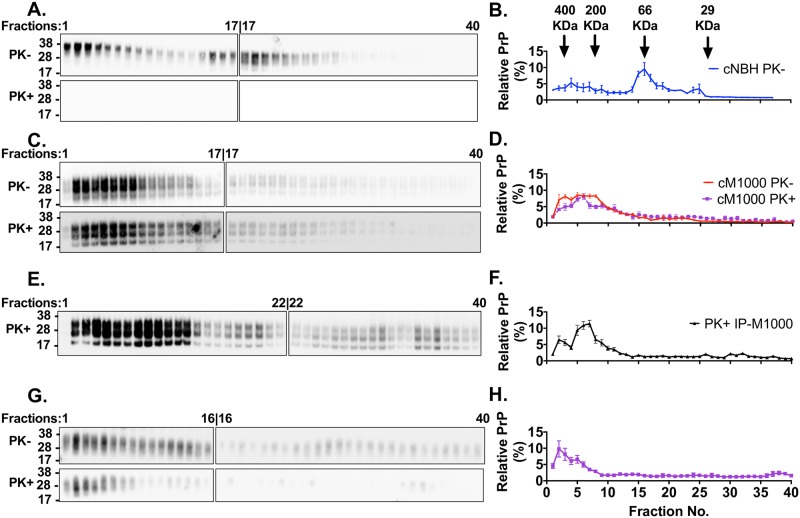
Prion acute synaptotoxicity is associated with increased levels of multimeric PrPSc species in ex vivo M1000 preparations.(A) Representative anti-PrP immunoblots of fractions collected following size exclusion chromatography of 10% (w/v) cNBH after clarifying centrifugation, solubilization in 4% (w/v) Sarkosyl and exhaustive dialysis. The fractions were immunoblotted before (-) and after (+) mild PK treatment (PK; 5μg/mL PK; incubated at 37°C for an hour). (B) Densitometric analysis of the immunoblots of cNBH fractions (n = 3) displayed as the percentage of PrP in each fraction over the sum of PrP levels in all the fractions. (C) Representative anti-PrP immunoblots of fractions collected following size exclusion chromatography of 10% (w/v) solubilized, dialyzed, and pre-cleared cM1000. The fractions were immunoblotted before (-) and after (+) mild PK treatment as described for (A). (D) Densitometric analysis of the immunoblots of cM1000 fractions (n = 3). (E) Representative anti-PrP immunoblots of fractions collected following size exclusion chromatography of at least modestly PK-resistant PrPSc, extracted from 1% (w/v) cM1000 by immunoprecipitation (IP) and eluted by a mild PK digestion (5μg/mL PK at 37°C for an hour) before being concentrated (10-fold to be equivalent to 10% w/v), solubilized, dialyzed, and pre-cleared for the size fractionation (PK+IP-M1000). (F) Densitometric analysis of the immunoblots of PK+IP-M1000 fractions (n = 2). (G) Representative anti-PrP immunoblots of fractions collected following size exclusion chromatography of solubilized, dialyzed, and pre-cleared 10% (w/v) M1000 brain homogenates containing only ~30% of the total PrP following selective removal of ~70% by immuno-depletion (dM1000). The fractions were immunoblotted before (-) and after (+) mild PK treatment (5μg/mL PK at 37°C for an hour). (H) Densitometric analysis of the immunoblots of dM1000 fractions (n = 3). (D & H) The levels of fractionated PrP with and without PK treatment were overlaid for illustration purposes and cannot be compared quantitatively because they were analysed independently. The effective molecular weights of PrP species collected in fractions one through 12 were larger than 100kDa consistent with multimeric species while those collected in fractions 15 through 40 were smaller than 100kDa (Molecular weight markers are indicated as arrows above B. (A, C, E, and G) Since all 40 fractions could not be loaded onto one 26-well gel, two 26-well gels were used for immunoblotting of the fractions from one size exclusion chromatography experiment; importantly the last fraction on the first gel was also loaded as the first on the second gel, thereby allowing the levels of PrP on the second blot to be normalized to those on the first blot. The PrP species were probed by either anti-PrP 03R19 (in A, C, and G) and 8H4 (in E) antibody. (A, C, E, and G) Molecular weight markers are provided at left. (B, D, F, and H) The data are presented as mean ± SEM.